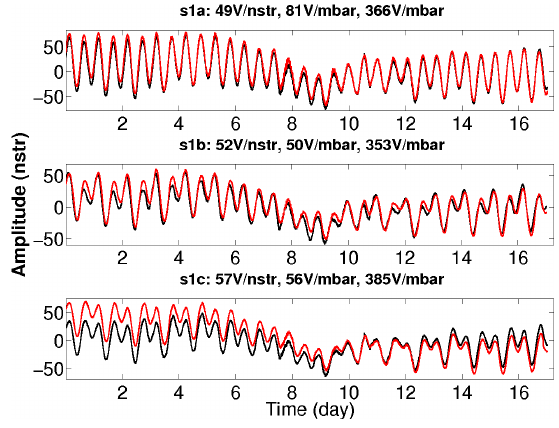
Figure 9. 17 days of strain records at MOK, june 2010: (red curves) detrended record of the strain on each component ; (black curves)totalstrainpredictionobtainedfromthelinearcom- bination of the effect of the predicted solid tide and of the recorded sea level and barometric pressure, according to the correlation coefficients of table 1.